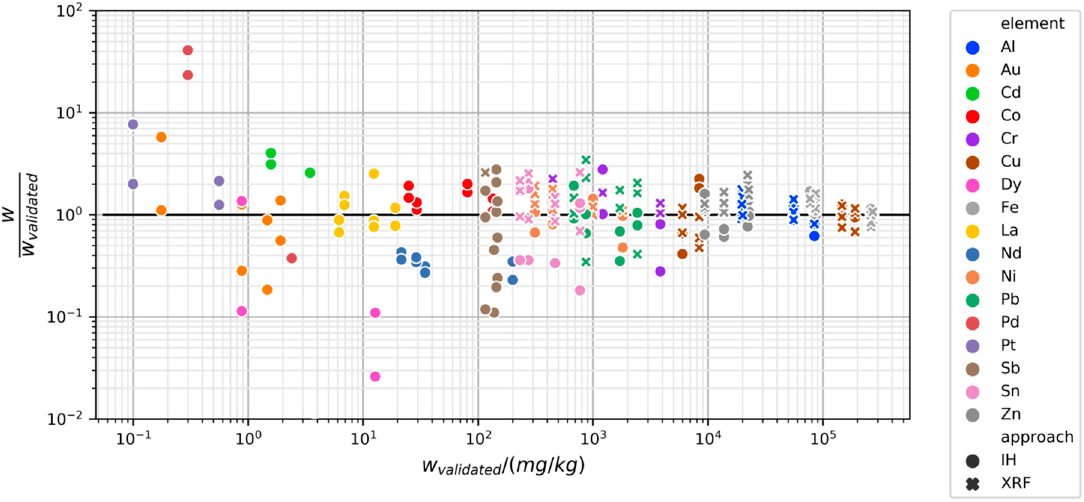
Figure 9. Mass fractions measured by in-house methods and XRF divided by corresponding mass fractions measured by validated methods ( y -axis) versus mass fractions measured by validated methods ( x -axis). Distance from the horizontal black line represents the deviation from validated result. Larger deviations are seen at low mass fractions.